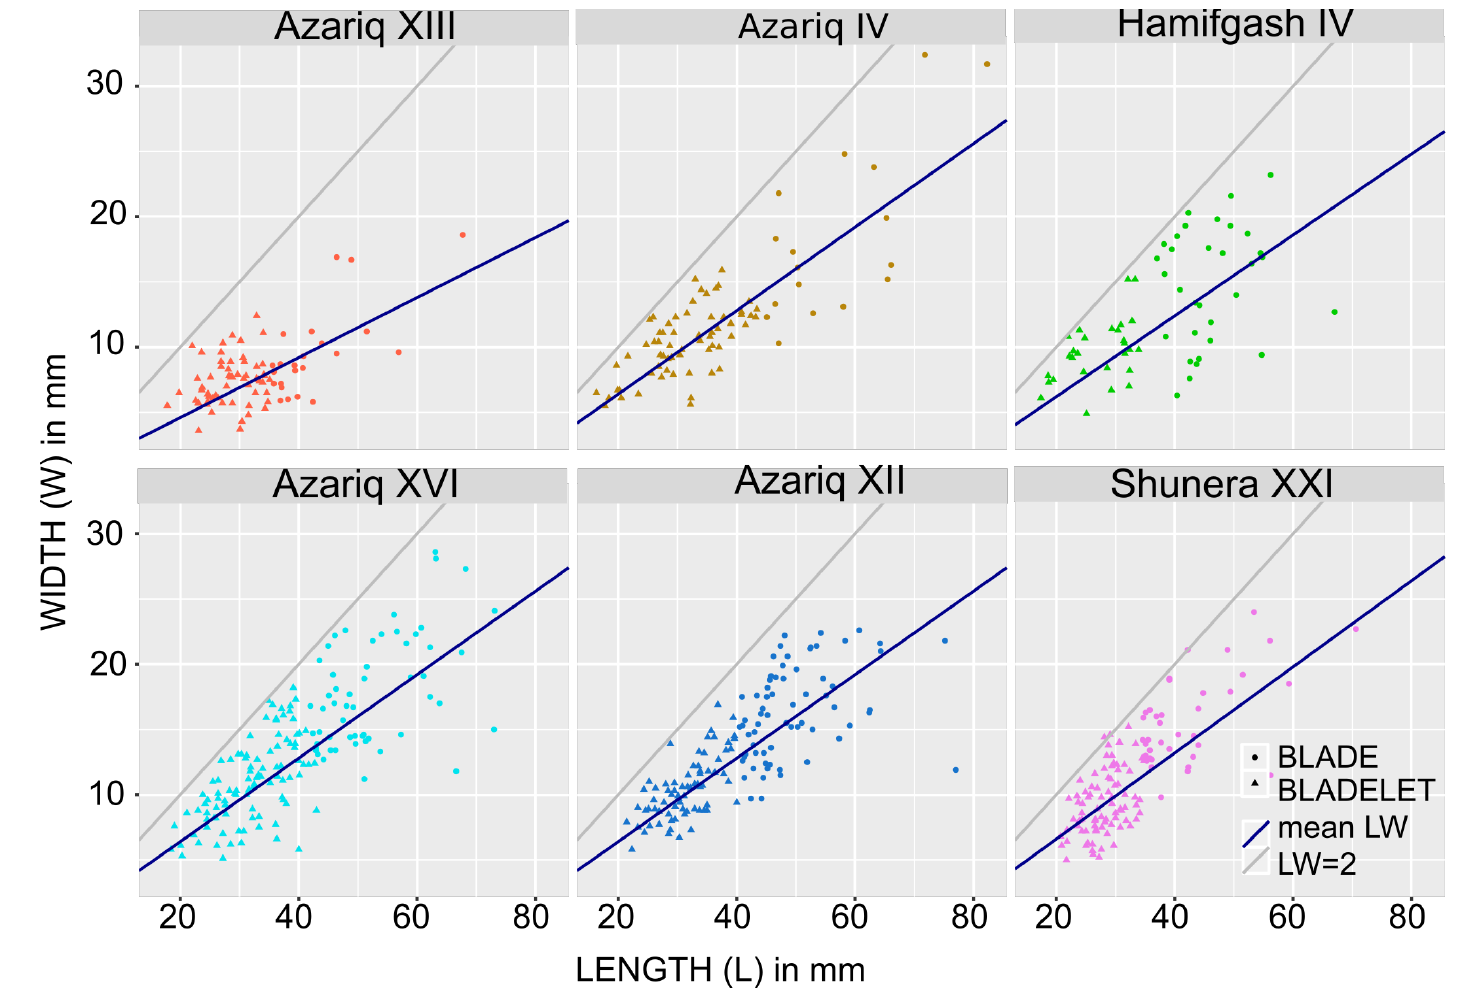
Figure 8. Biplot of length and width of complete elongated